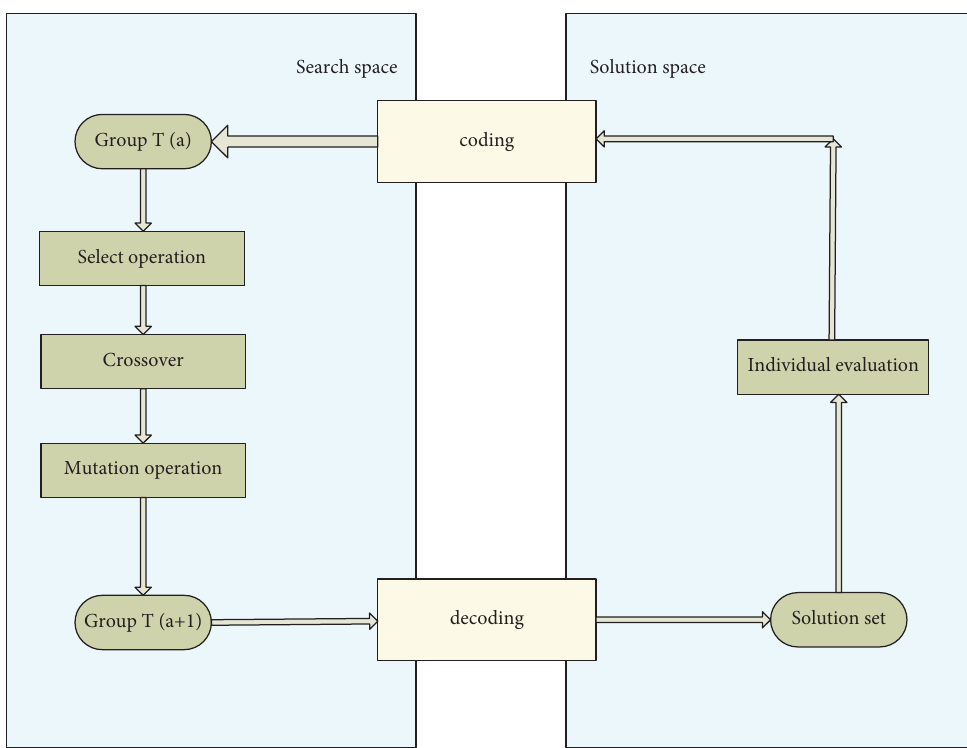
Figure 5: Schematic diagram of the operation process of genetic algorithm.